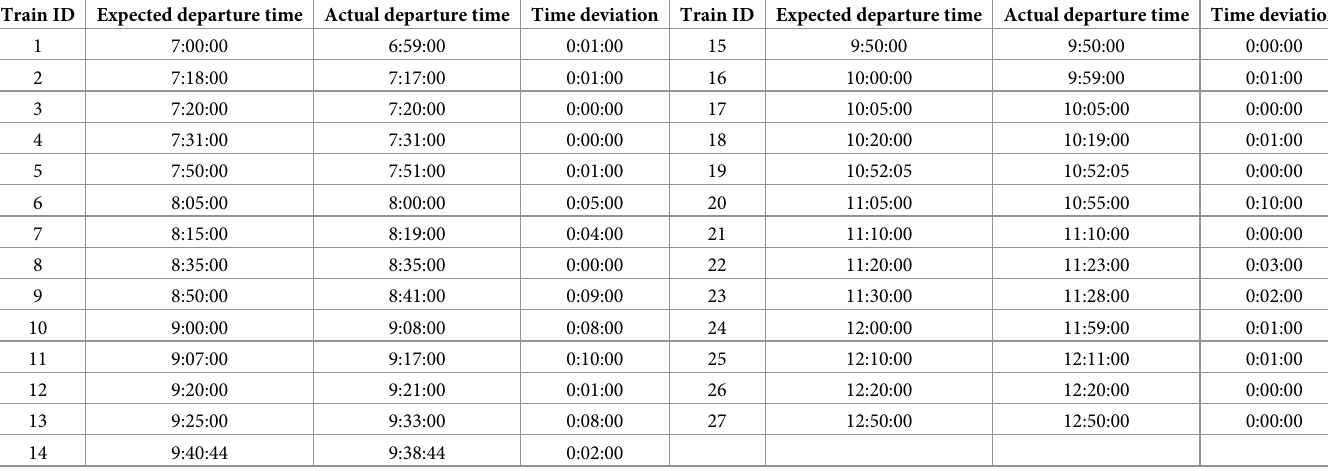
Table 12. The actual and expected departure times of each train from the origin